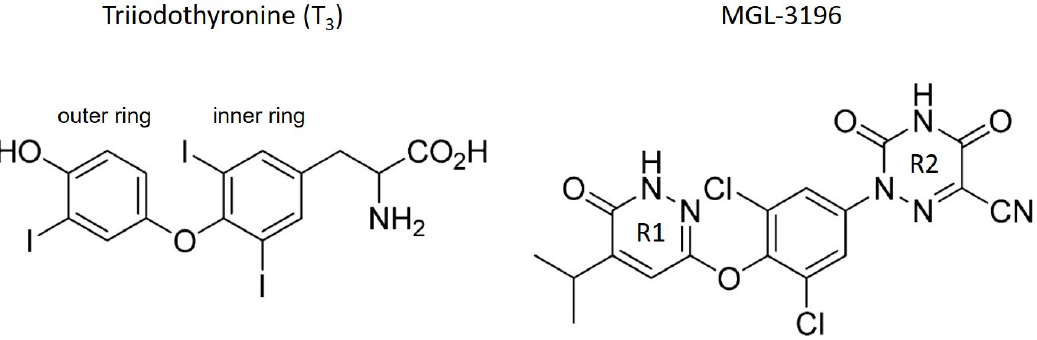
Figure 1. Structures of triiodothyronine (T 3 ) and MGL-3196. In comparison to the structure of T 3 , the phenolic outer ring is replaced by a pyridazinone ring (R1) in MGL-3196, resulting in a heterocyclic structure. Instead of the α -amino acid group, MGL-3196 possesses an azauracil residue with a cyano group (R2) ([11]).